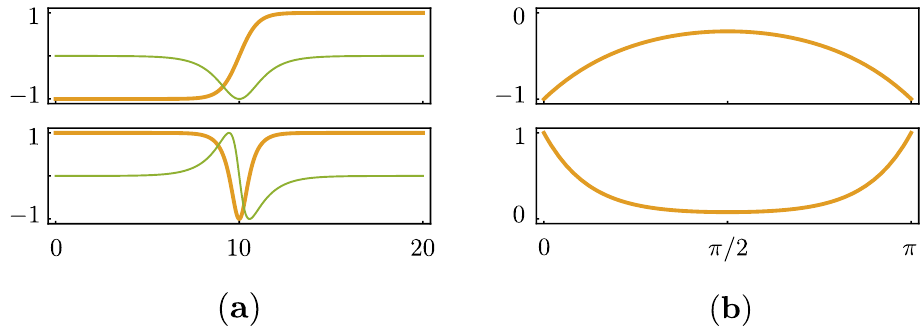
Figure 8 . Panel (a) shows the behaviour of two types of CDD resonances for real (cid:18) . The upper and lower plots show [ (cid:25)= 2 + 10 i ] and [ (cid:25)= 5 10 i ][ (cid:25)= 5 + 10 i ] respectively. The thick orange (cid:0) (cid:0) (cid:0) (cid:0) curve is the real part while the thin green curve is the imaginary part. Resonances can be added at very little cost. If some parameters are large, for example, their e(cid:11)ect only shows up at very high energies nearly not a(cid:11)ecting low energy physics. Panel (b) shows the behaviour of two resonance factors for (cid:18) purely imaginary between 0 and i(cid:25) . The upper and lower panel show [ (cid:25)= 2 + i ] and (cid:0) [ (cid:25)= 3 i ][ (cid:25)= 3 + i ] respectively. In the former case the resonance factor is purely real in this (cid:0) (cid:0) (cid:0) interval while in the later case the product is real although the individual factors are not. Note that in this interval CDD resonances always have magnitude less than 1 and that each individual CDD resonances never changes